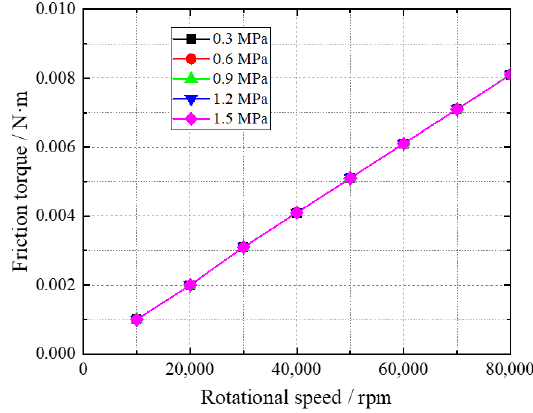
Figure 10. Friction torque of hydrogen gas bearings with ambient pressure.